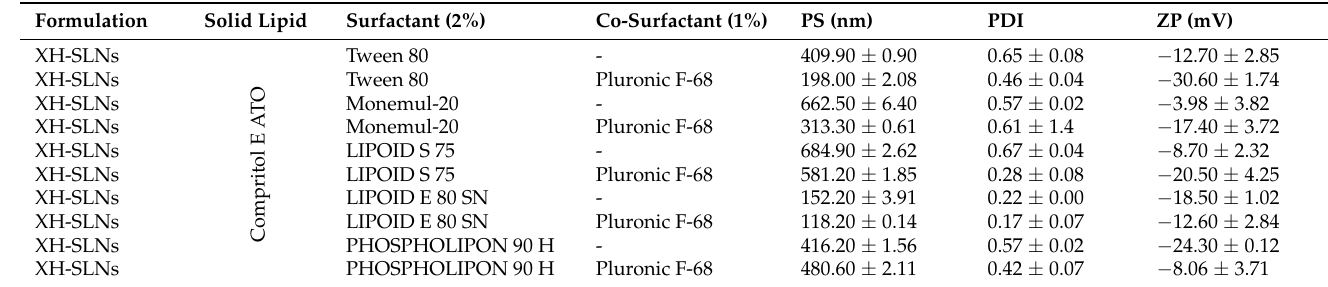
Table 2. Formulations of XH-SLNs with various surfactants and co-surfactants. Formulation Solid